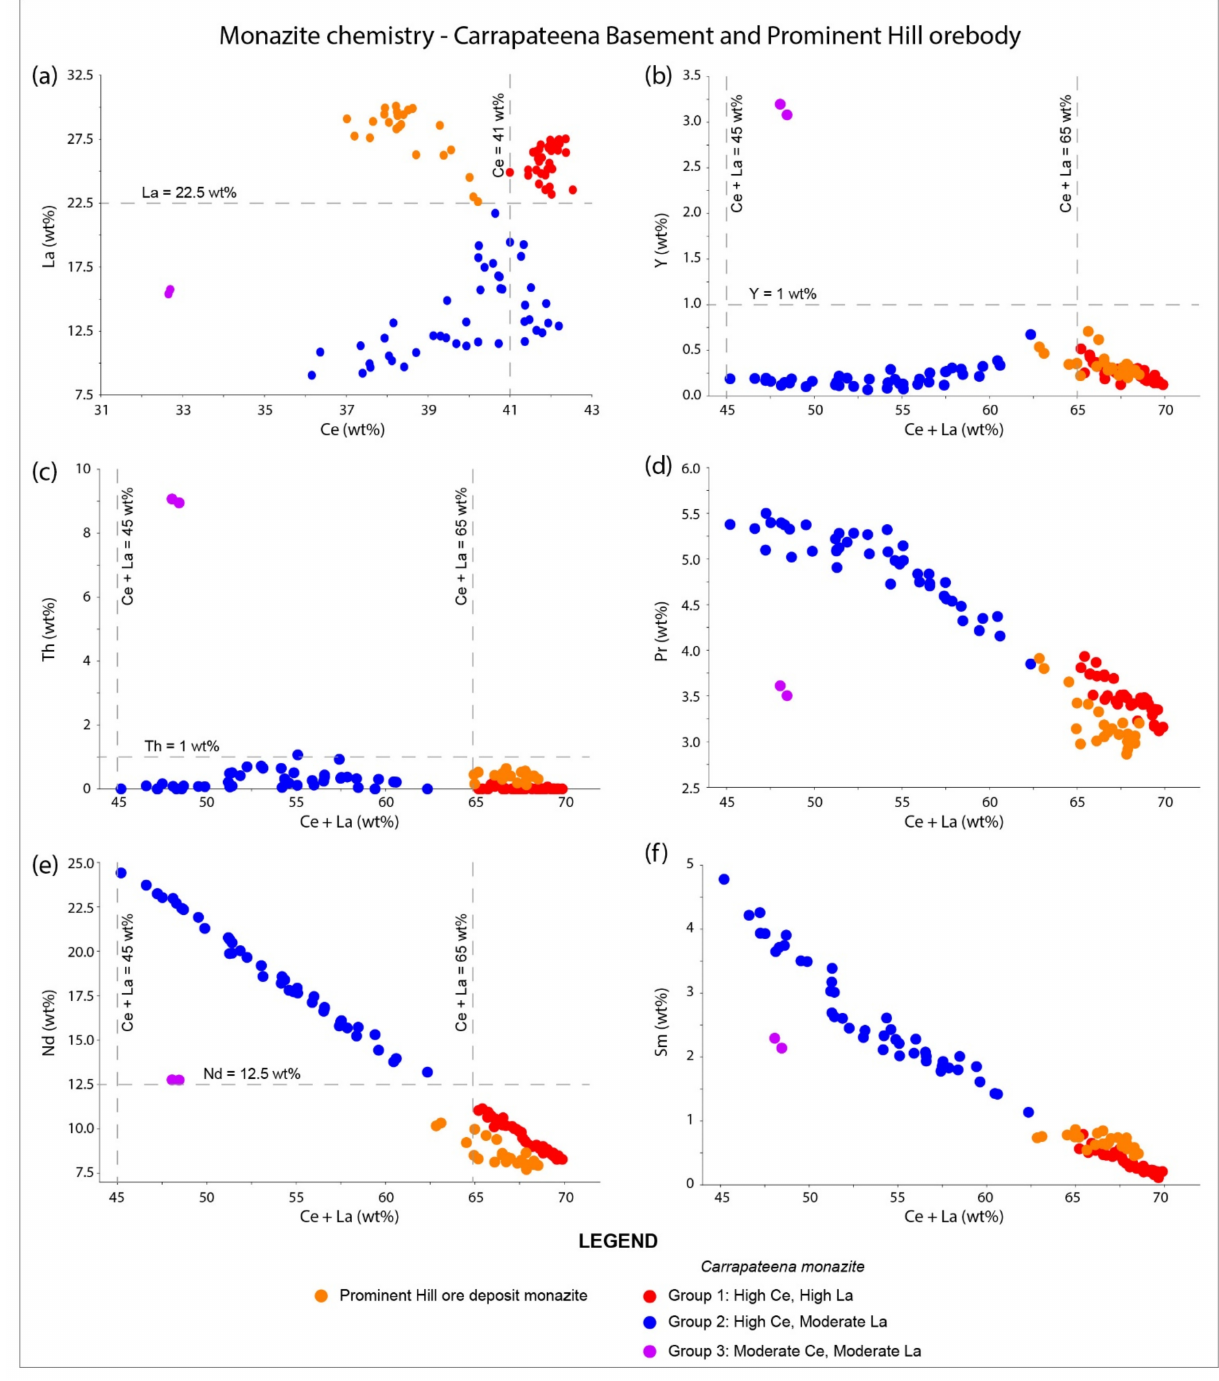
Figure 6. Geochemical plots for monazite from the Carrapateena basement samples and the Prominent Hill deposit. ( a ) Ce vs. La; ( b – f ): Ce +La vs. ( b ) Y; ( c ) Th; ( d ) Pr; ( e ) Nd; and ( f ) Sm. Thresholds defining Group 1 and Group 2 basement monazite are shown in ( a – f ). ILRLa_Ce = Hill orebody taken from